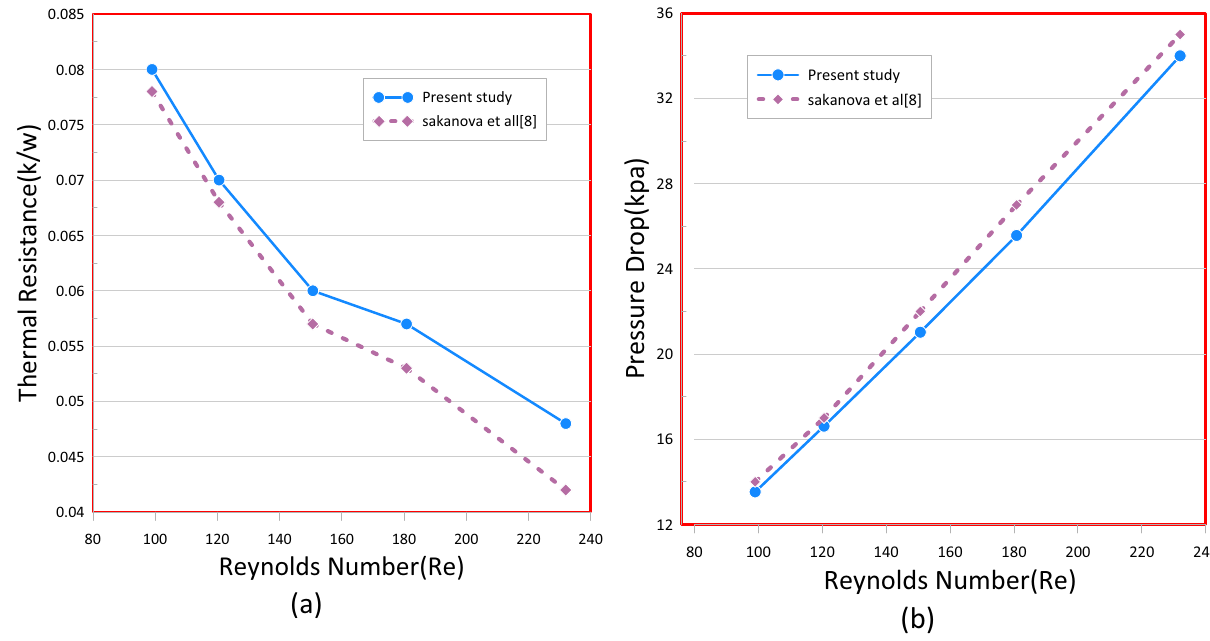
Figure 8. ( a ) Thermal resistance and ( b ) pressure drop dependence on Re for rectangular MCHS using diamond (5%)–water nanofluid as the coolant.